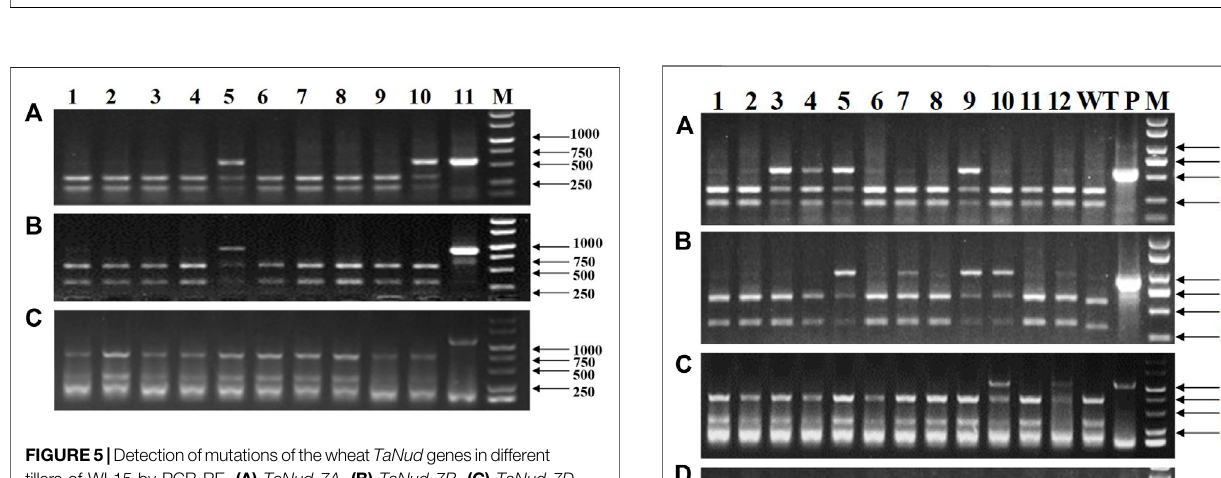
FIGURE 4 | Detection of SpCas9 and bar genes in different tillers of WL8 by PCR and QuickStix strips, respectively. (A) Detection of SpCas9 gene by PCR. 1 – 11: different tillers of WL8; WT: wild type by PCR-RE; P: PCR products without digestion; M: DNA marker. (B) Detection of Bar protein by QuickStix strips. (C) Schematic diagram of conjoined transgenic wheat plant WL8. +: positive tiller; − : negative tiller.